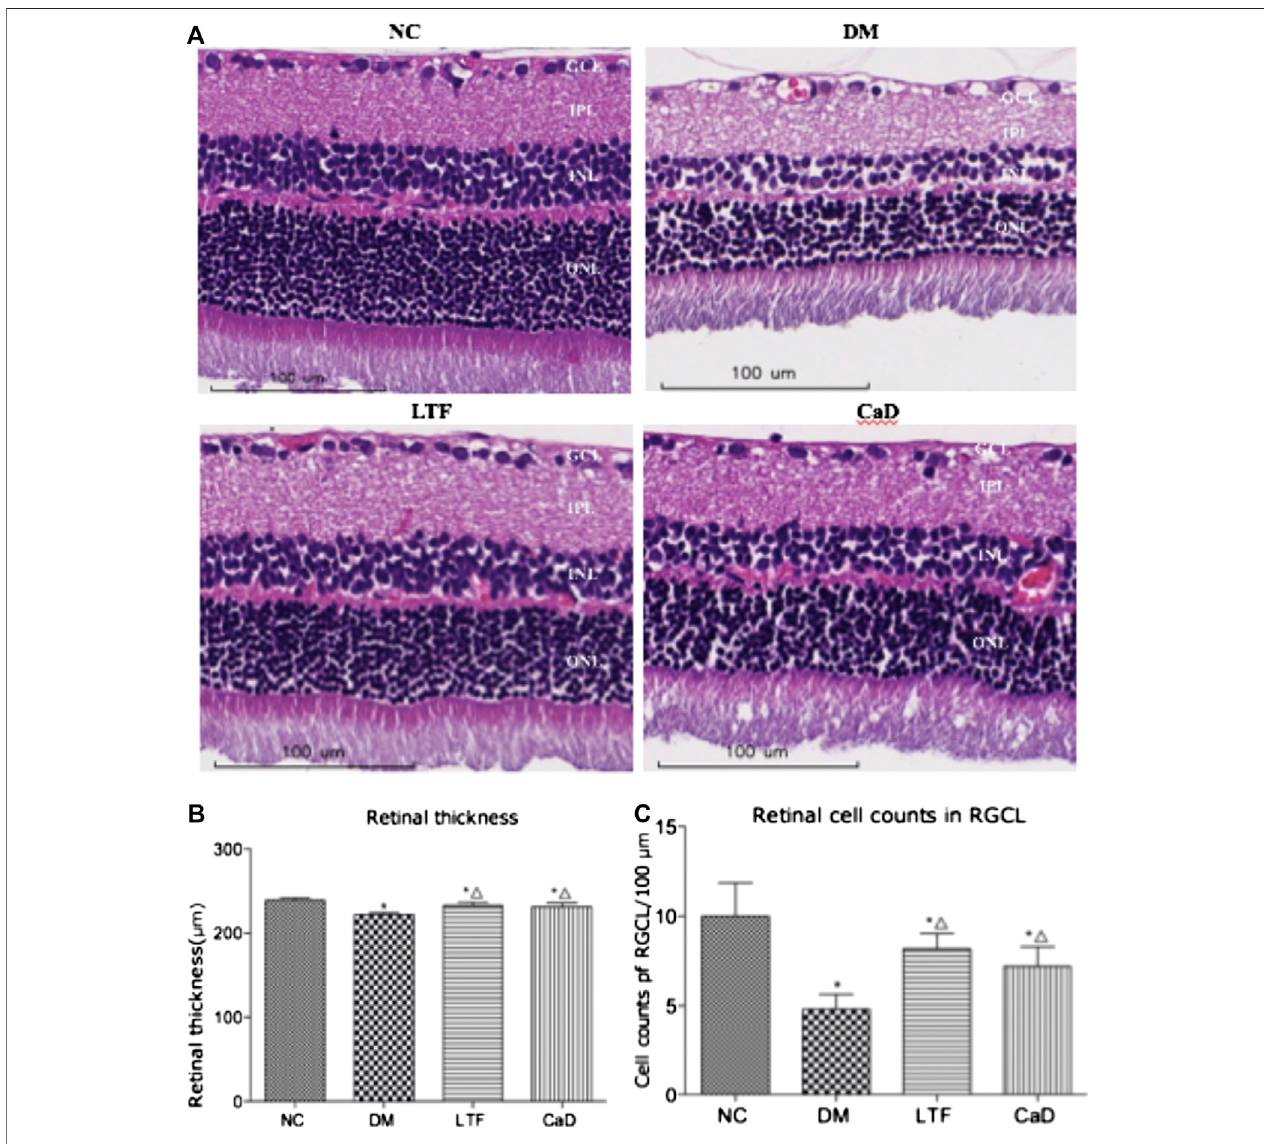
FIGURE 3 | Effect of LTF and CaD on the retinal morphological changes. (A) HE staining of retina at 12 weeks ( × 400 magni fi cation); (B) Toral retinal thickness; (C) Cell counts in the GCL; (B – C) Data are mean ± SD from six retinas per group. (* p < 0.05: vs. NC group; △ p < 0.05: vs. DM group).